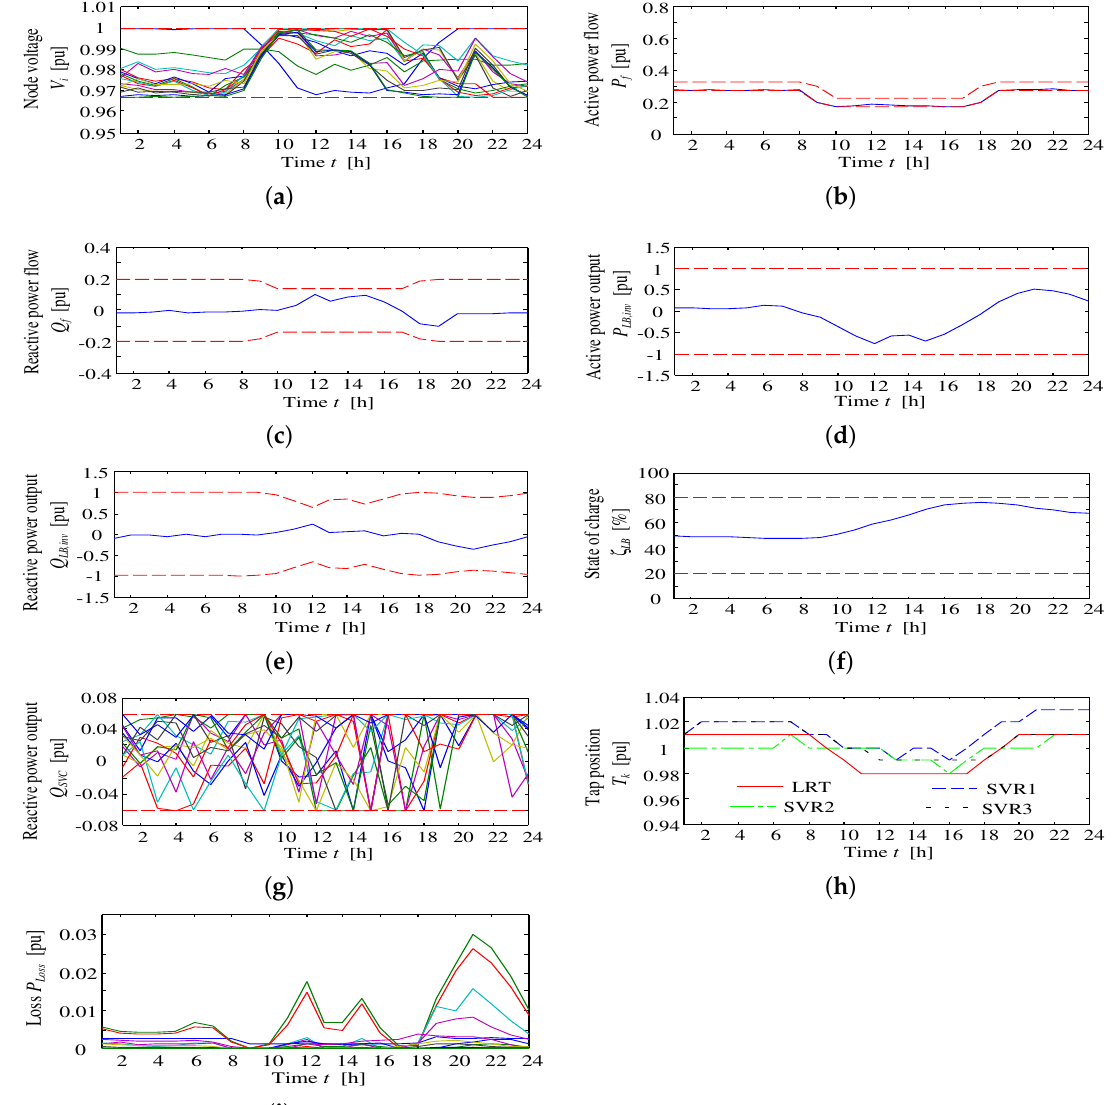
Figure 9. Simulation results of the comparison method (Case 2). ( a ) Voltage profile without control, ( b ) active power flow at the interconnection point and ( c ) reactive power flow at the interconnection point. ( d ) Active power output of large BESS. ( e ) Reactive power output of large BESS. ( f ) SOC of large BESS. ( g ) SVC output. ( h ) Tap position of on-load tap changers (OLTCs) (LRT and SVRs). ( i ) Distribution losses of each node over